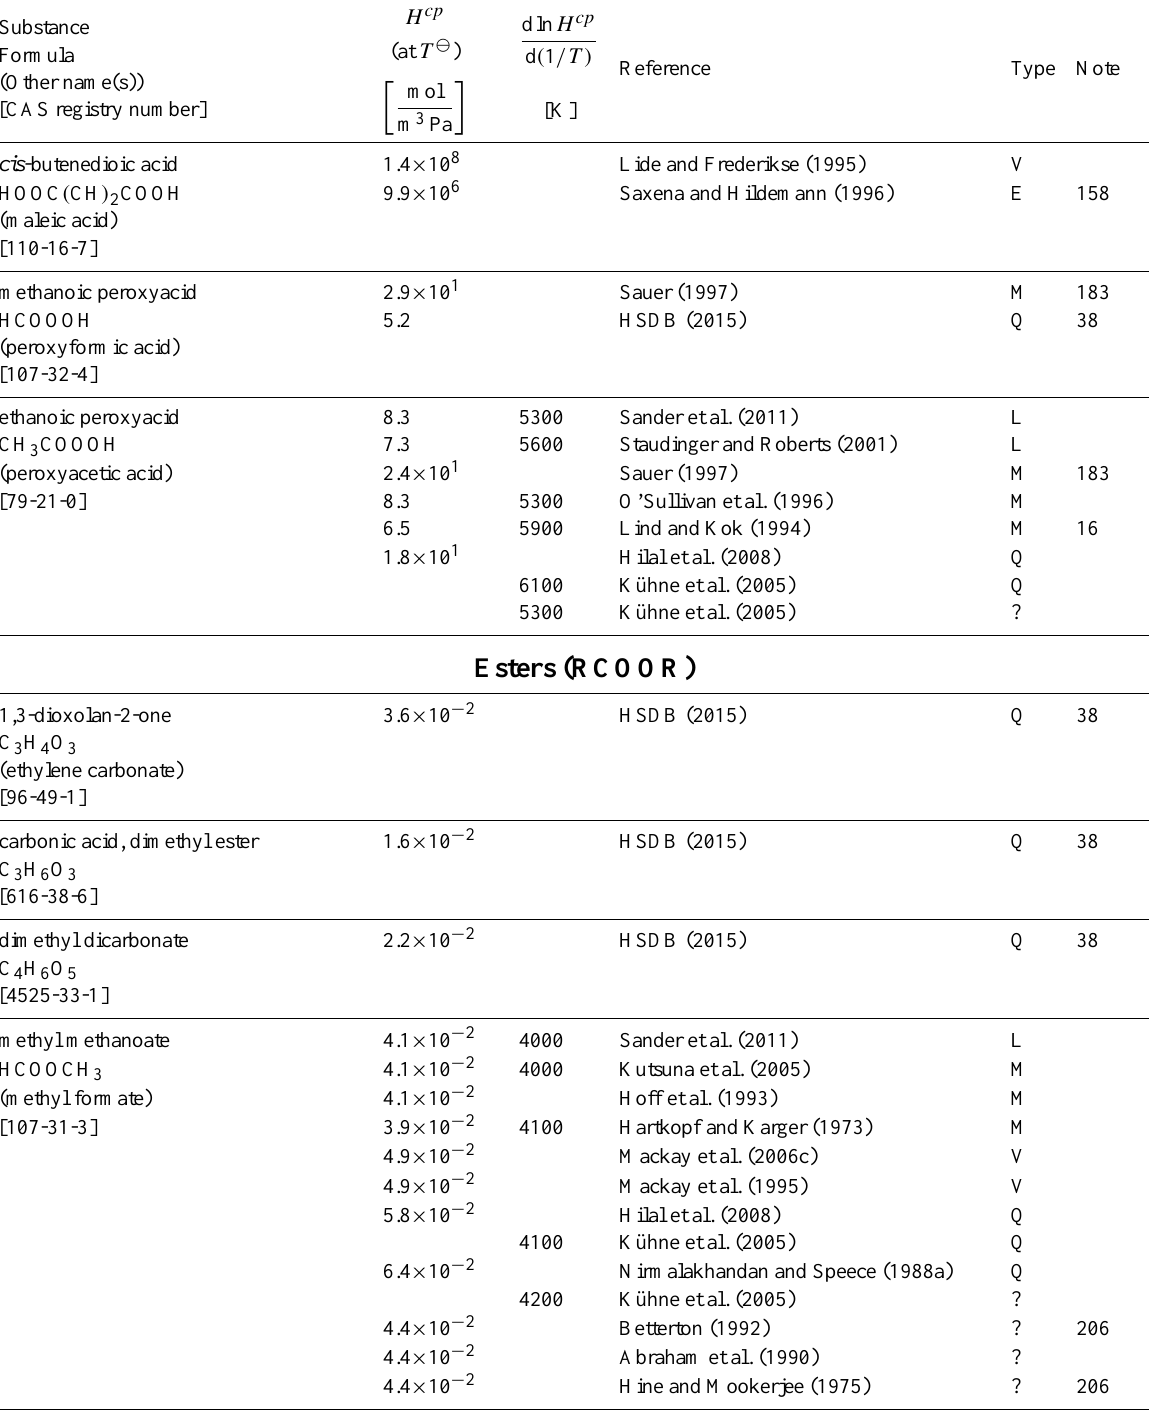
Table 6: Henry’s law constants for water as solvent